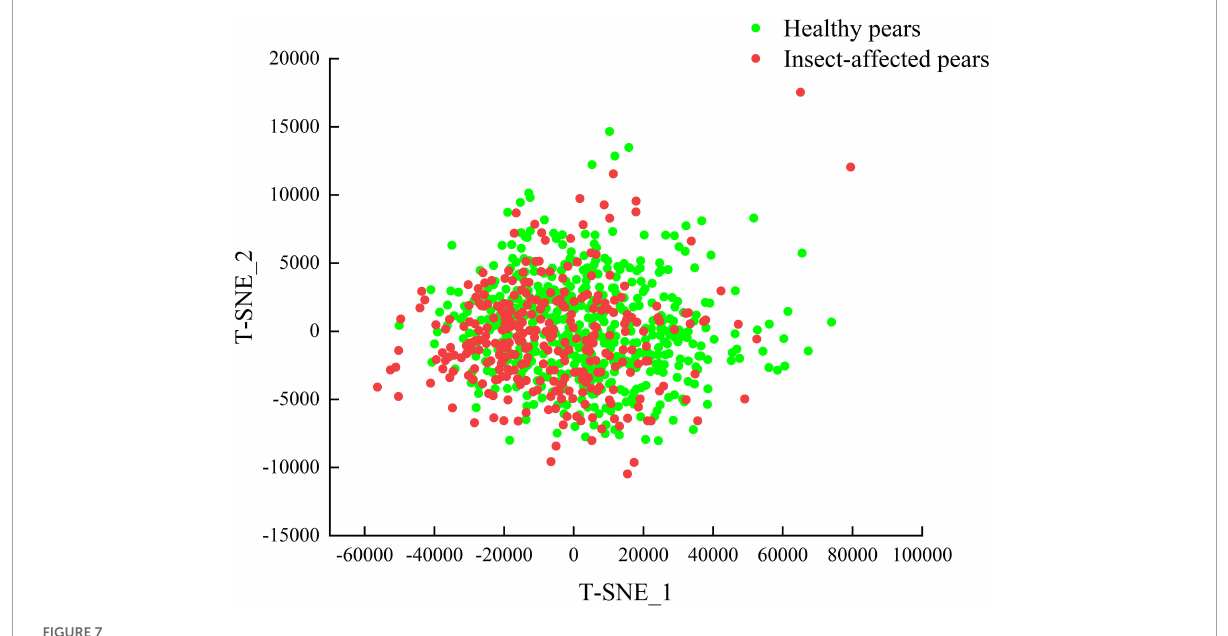
FIGURE7 Feature visualization of healthy pears and insect-affected